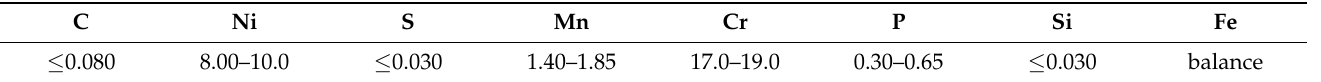
Table 3. Test factors and level comparison table (Alpha = 2) .